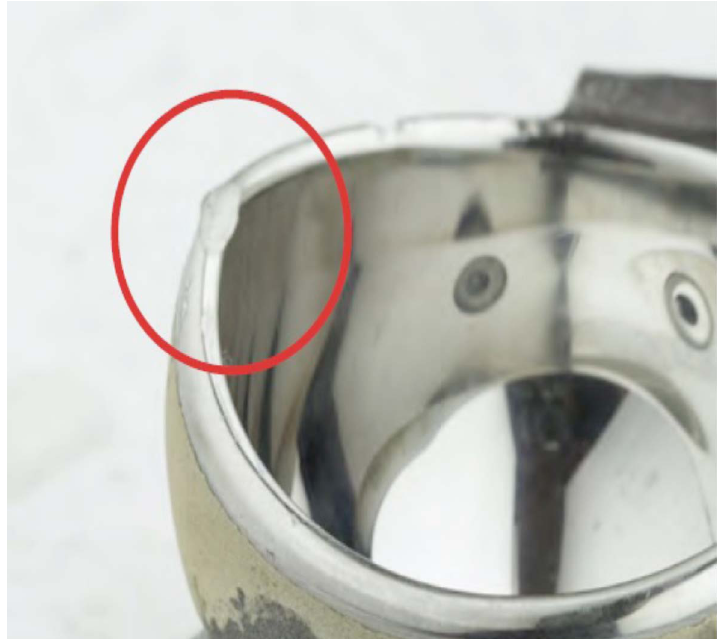
Figure 7. Impingement of the neck on shell.